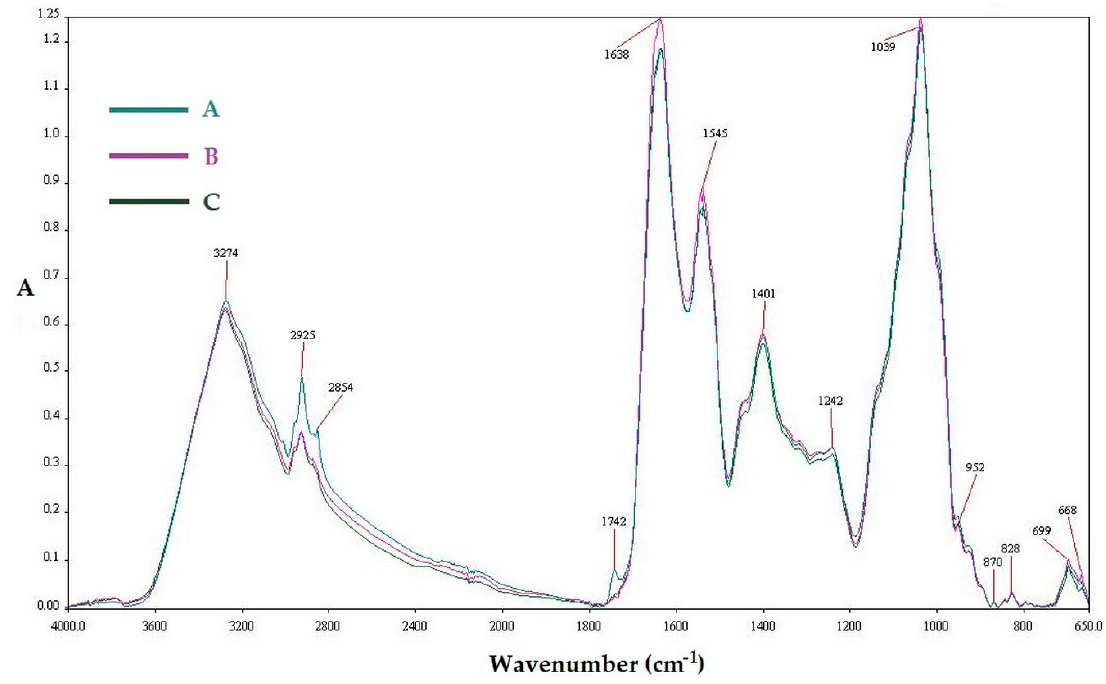
Figure 1. FTIR spectra of FOCE spray-dried powders; A—powder obtained at 160 °C; B—powder obtained at 180 °C; and C—powder obtained at 200 °C.